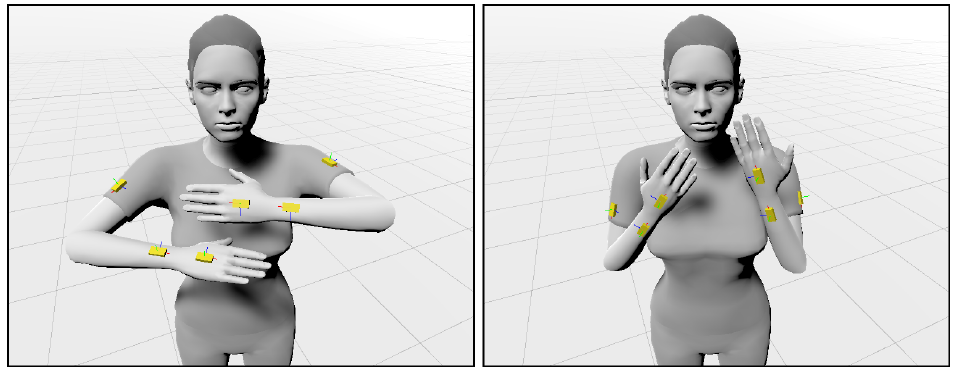
Figure 1. Motion capturing animation from limb-mounted IMU sensors. Horizonal ( left ), Vertical ( right